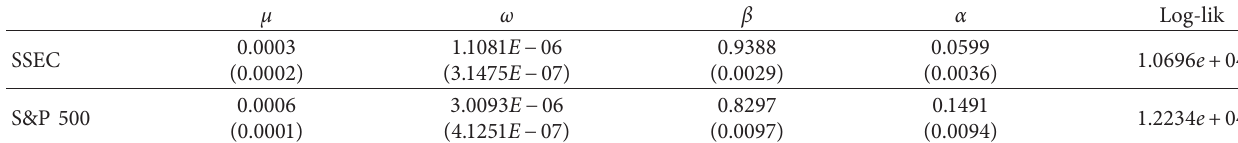
Table 4: Estimation results for the marginal distribution